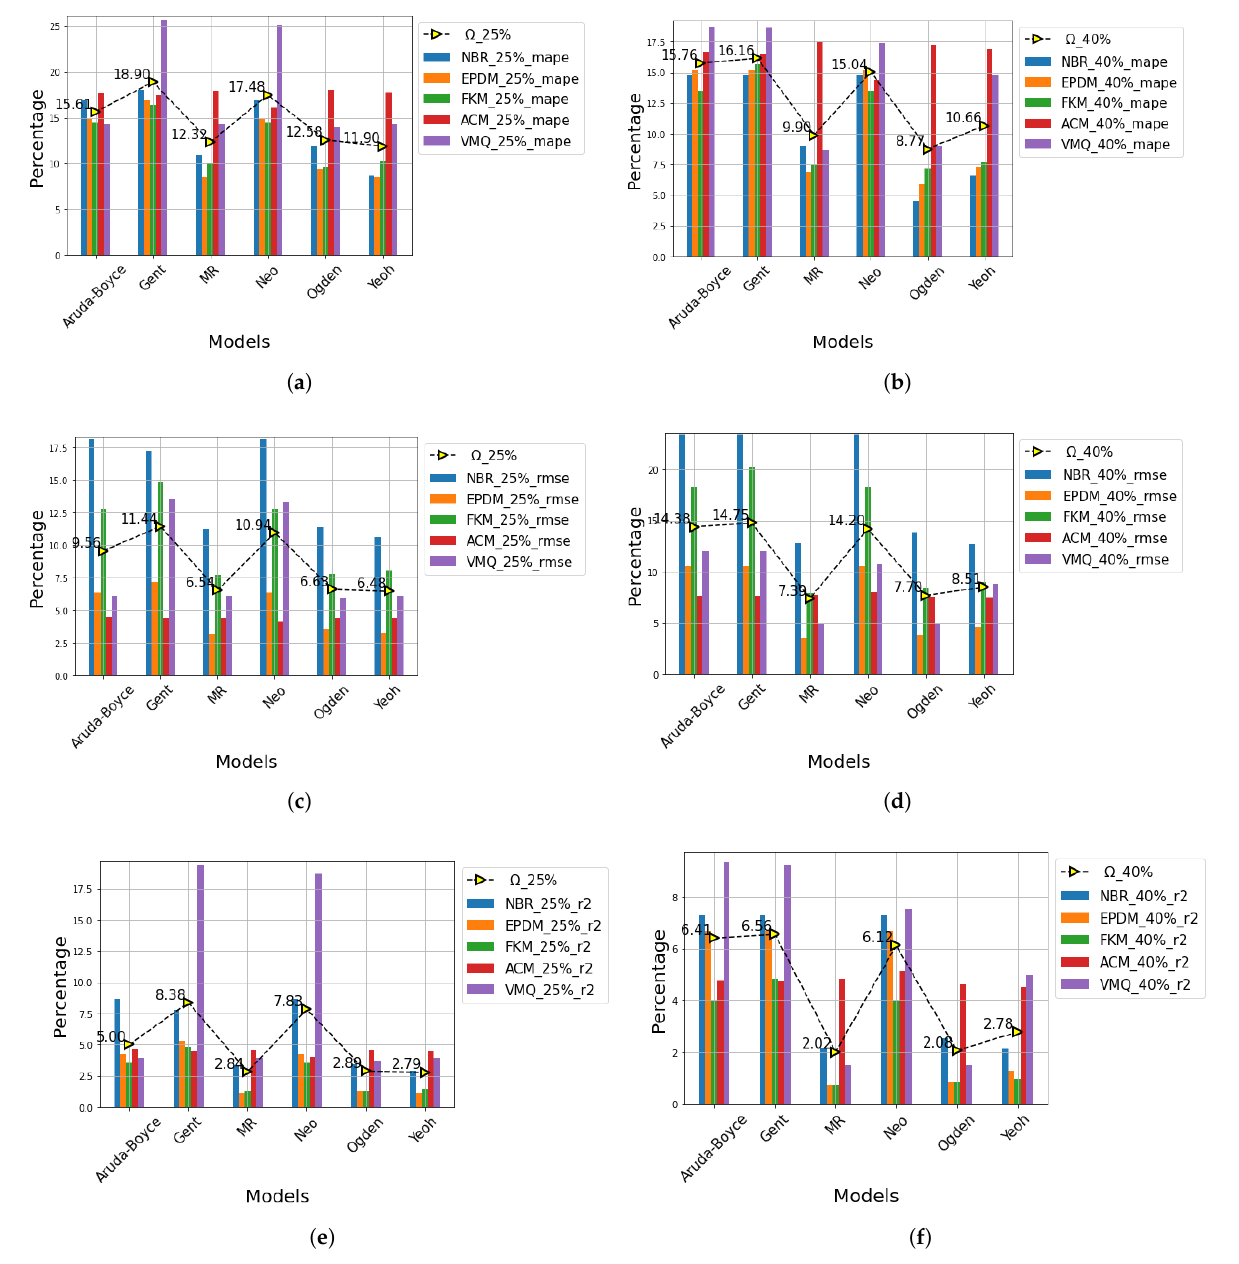
Figure 8. Curve similarity assessment of RLM per hyperelastic model ( a ) MAPE at 25% displacement, ( b ) MAPE at 40% displacement, ( c ) RMSE at 25% displacement, ( d ) RMSE at 40% displacement, ( e ) R2 at 25% displacement, and ( f ) R2 at 40%